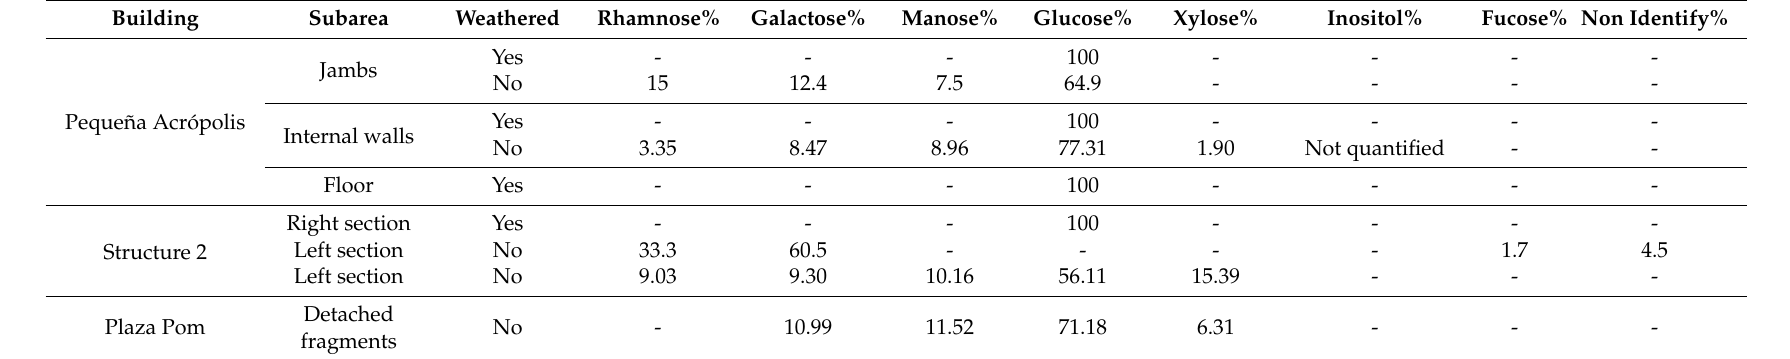
Table 12. Quantities of monosaccharides in the studied